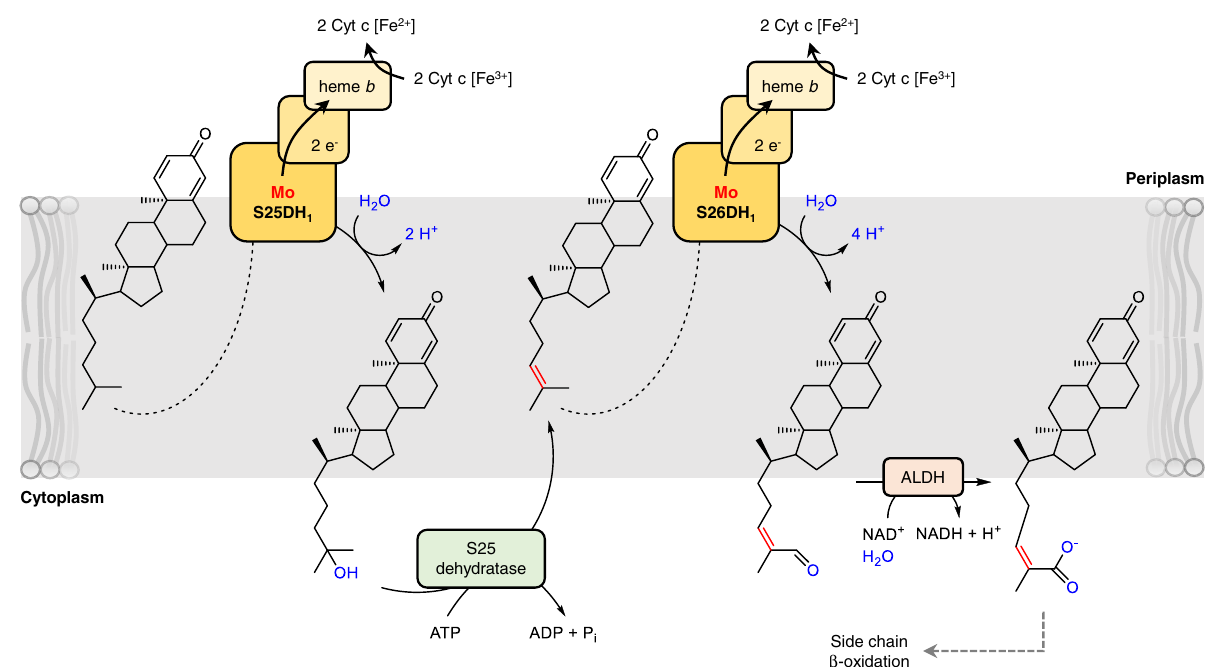
Fig. 5 Proposed subcellular localisation of initial anaerobic cholesterol degradation steps. For easier presentation, reduction of Δ 24 double bond is omitted. The dotted arrows indicate that hydrophobic side chain needs to be bound by S25DH 1 and S26DH 1 . The assignment of S25DH 1 and S26DH 1 to the periplasm are based on their TAT sequence, that of S25 dehydratase and aldehyde dehydrogenase (ALDH) to the cytoplasm on their cytoplasmic co- substrates. Hydroxylations at C25 and C26 abolish polarity of CDO/DDO and improves access from both sides of the cytoplasmic